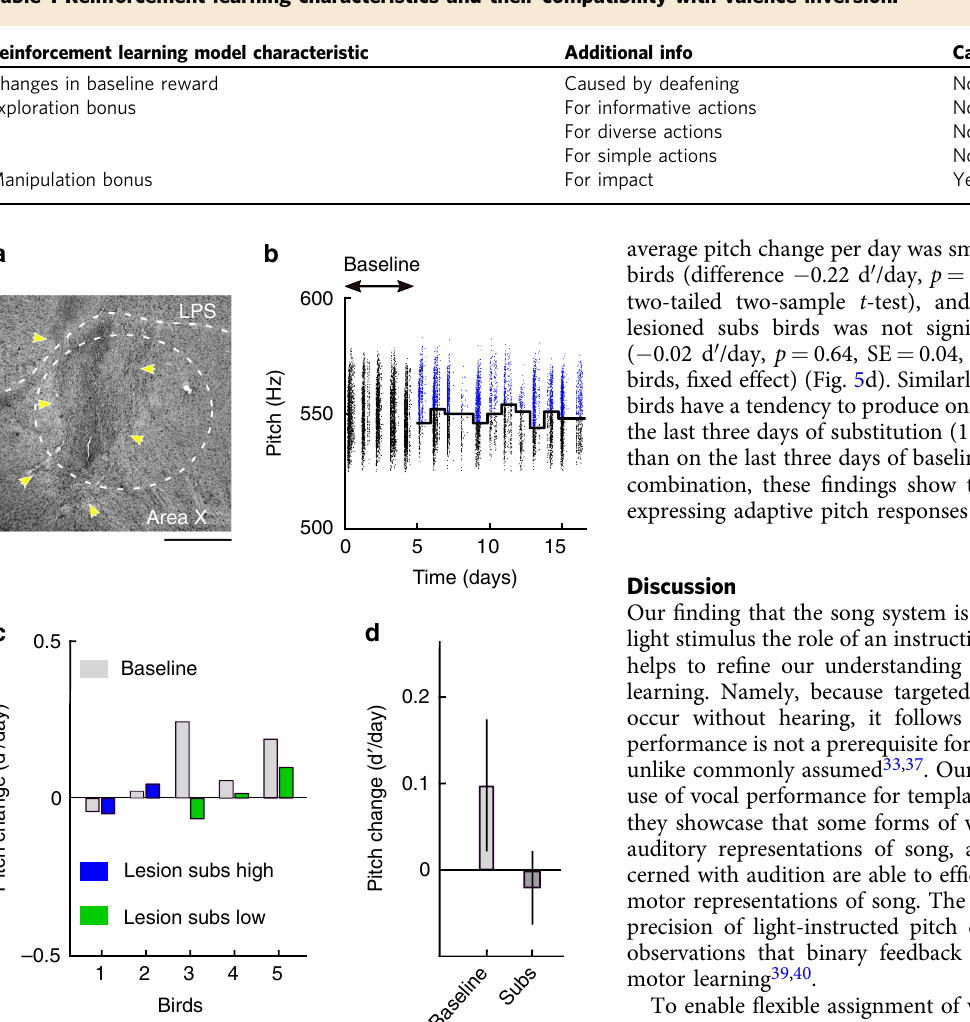
Table 1 Reinforcement learning characteristics and their compatibility with valence inversion.